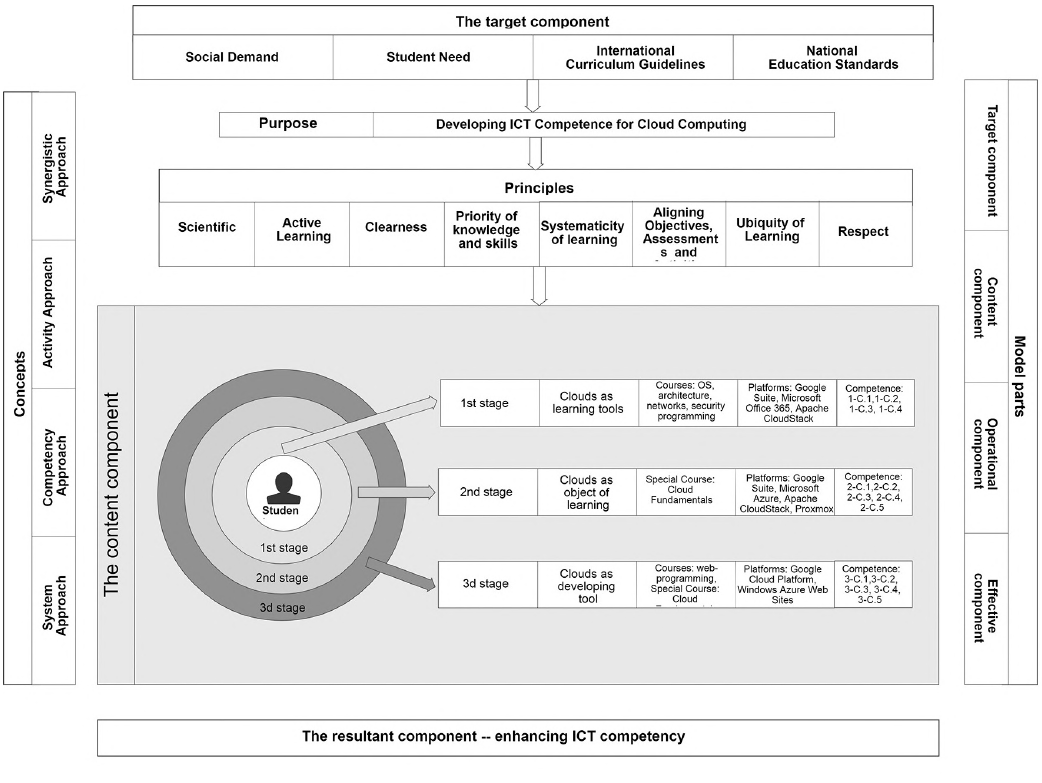
Figure 26: Presentation of paper